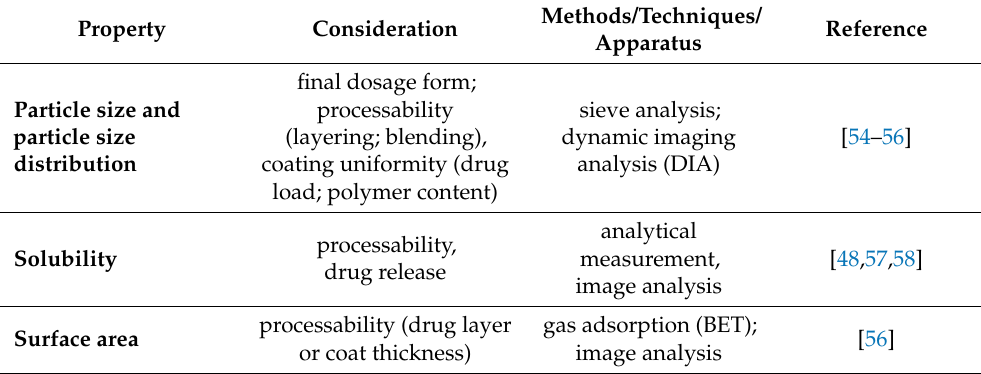
Table 2. Characteristic inert pellet core that can affect the quality of the final